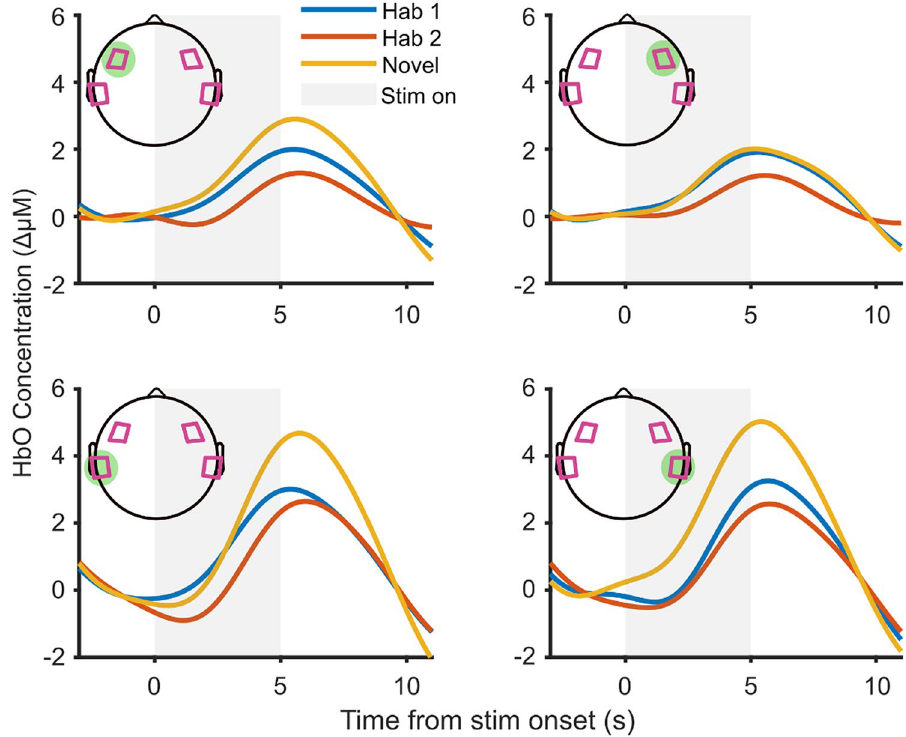
Figure 6. Group HbO responses at each ROI and to the Hab 1, Hab 2 and Novel stimulus conditions. Each ROI’s responses are in a different panel, with the ROI indicated by highlight on the head montage illustration. Each trace represents the response averaged across